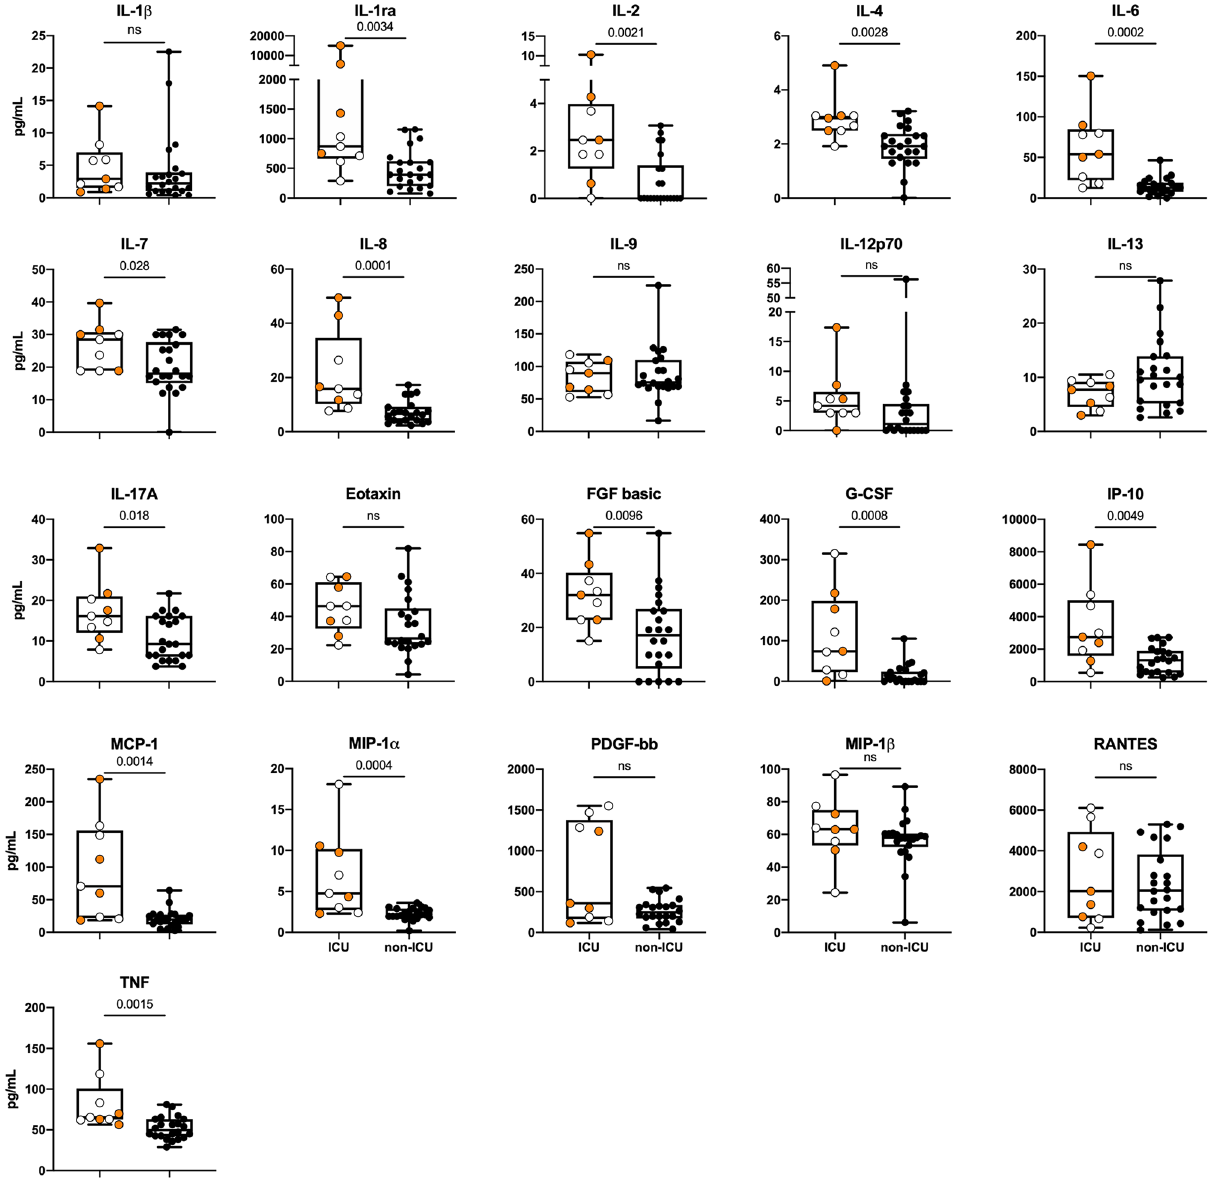
Figure 3. Cytokine levels in COVID-19 patients in ICU compared to non-ICU. Cytokine levels in patients with (n = 9) or without (n = 22) treatment in ICU. For three patients baseline samples were not available and these were excluded from the analysis set. Groups were compared using Mann U Whitney test, significance <